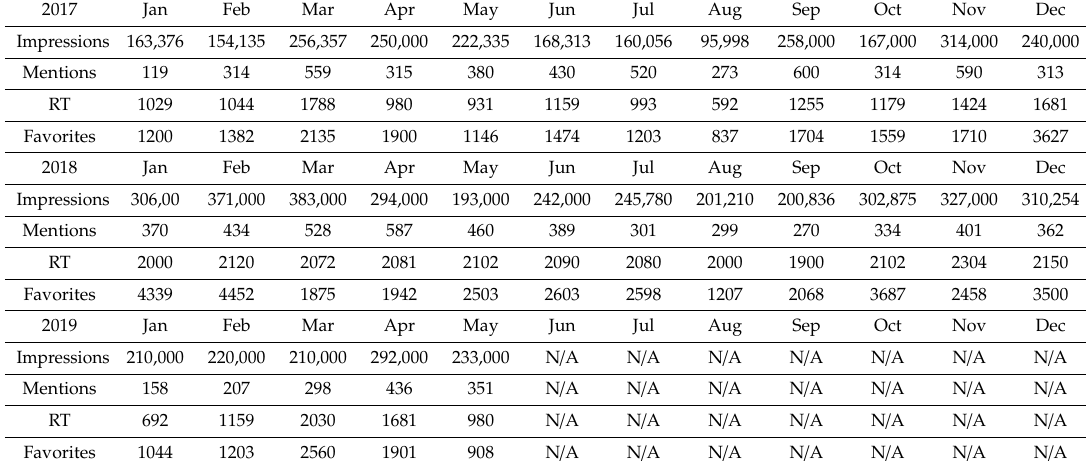
Table 5. CEE impact indicators on Twitter